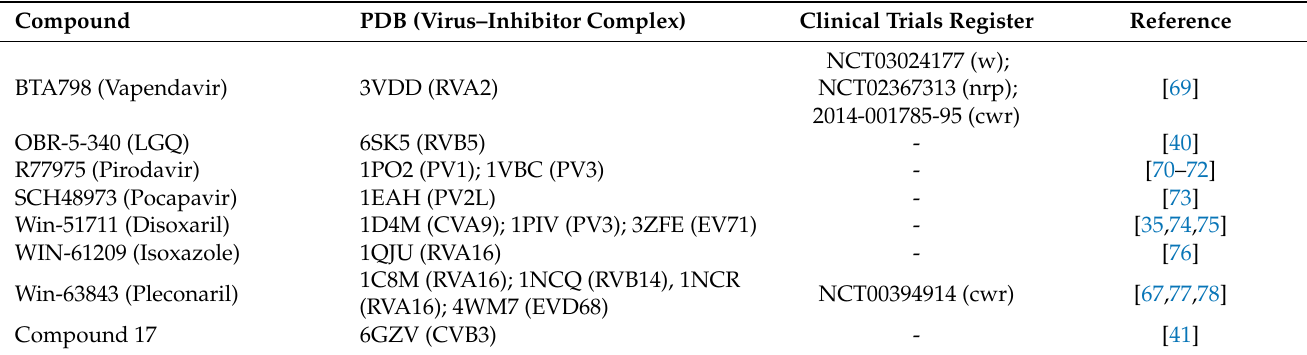
Table 1. List of compounds targeting a capsid pocket *.